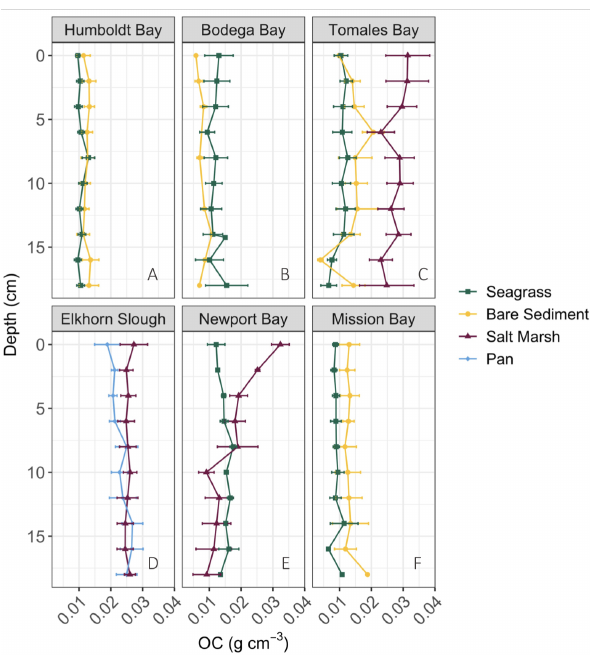
Figure 2. Down core trends (surface = 0cm) in average ( ± SE) OC (gcm − 3 ) for each habitat type and site. Data show an insignificant decline in OC through time (downcore) in all sites except Newport Bay salt